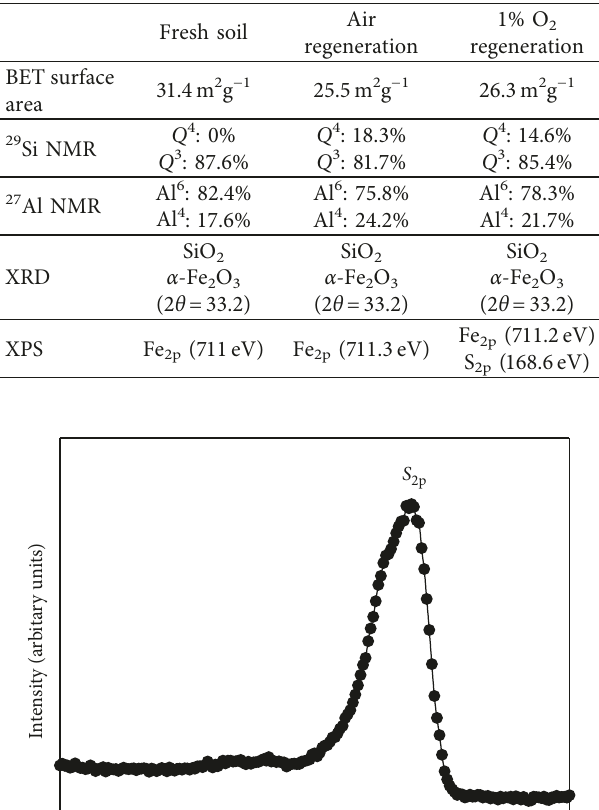
Table 2: Spectroscopic and surface area analyses of the lateritic soil under different regenerating